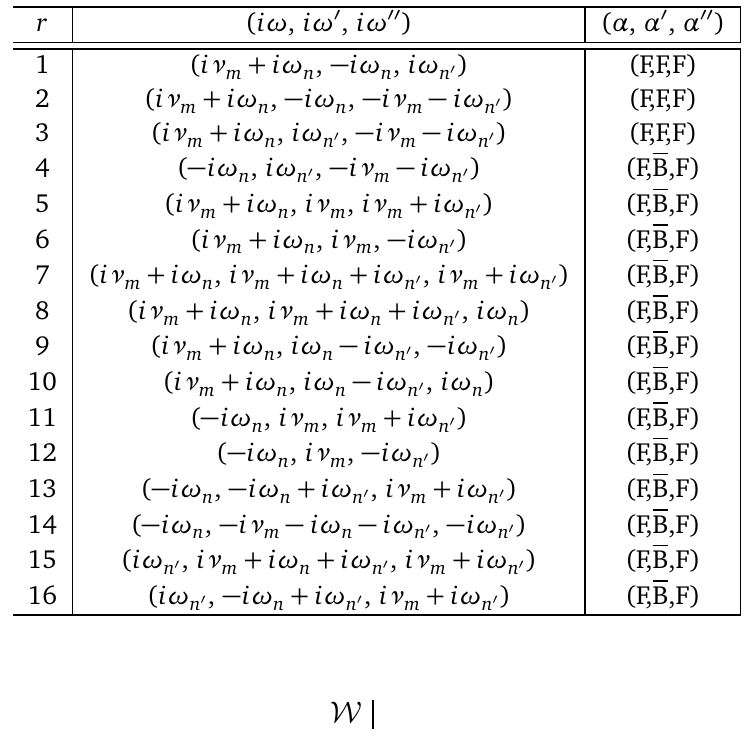
Table 1: 16 different notations of Matsubara frequencies and statistics for the four- point Green’s functions G . Adapted from Ref. [ 22 ] .